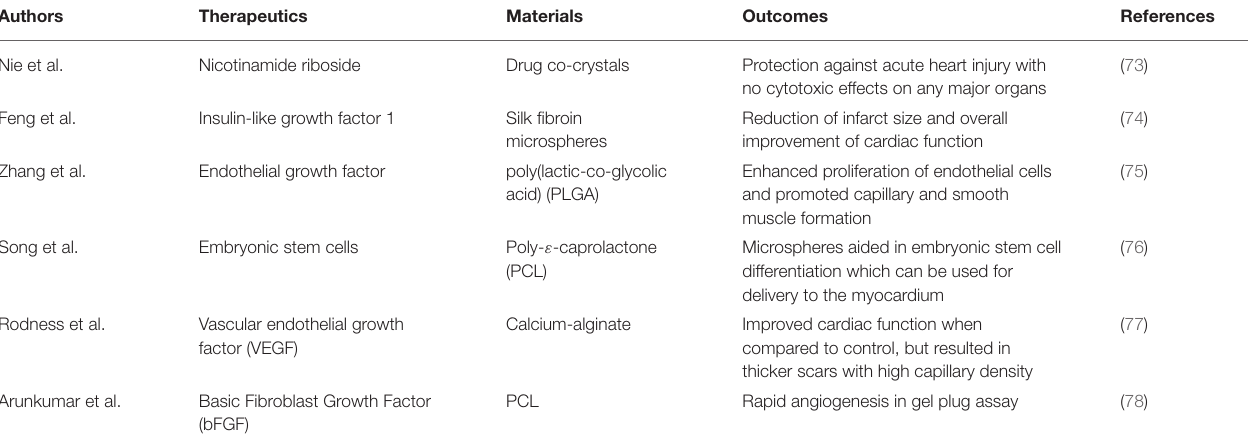
TABLE 2 | Microparticle based formulations used as a depot for sustained delivery of growth factors aiding in cardiac